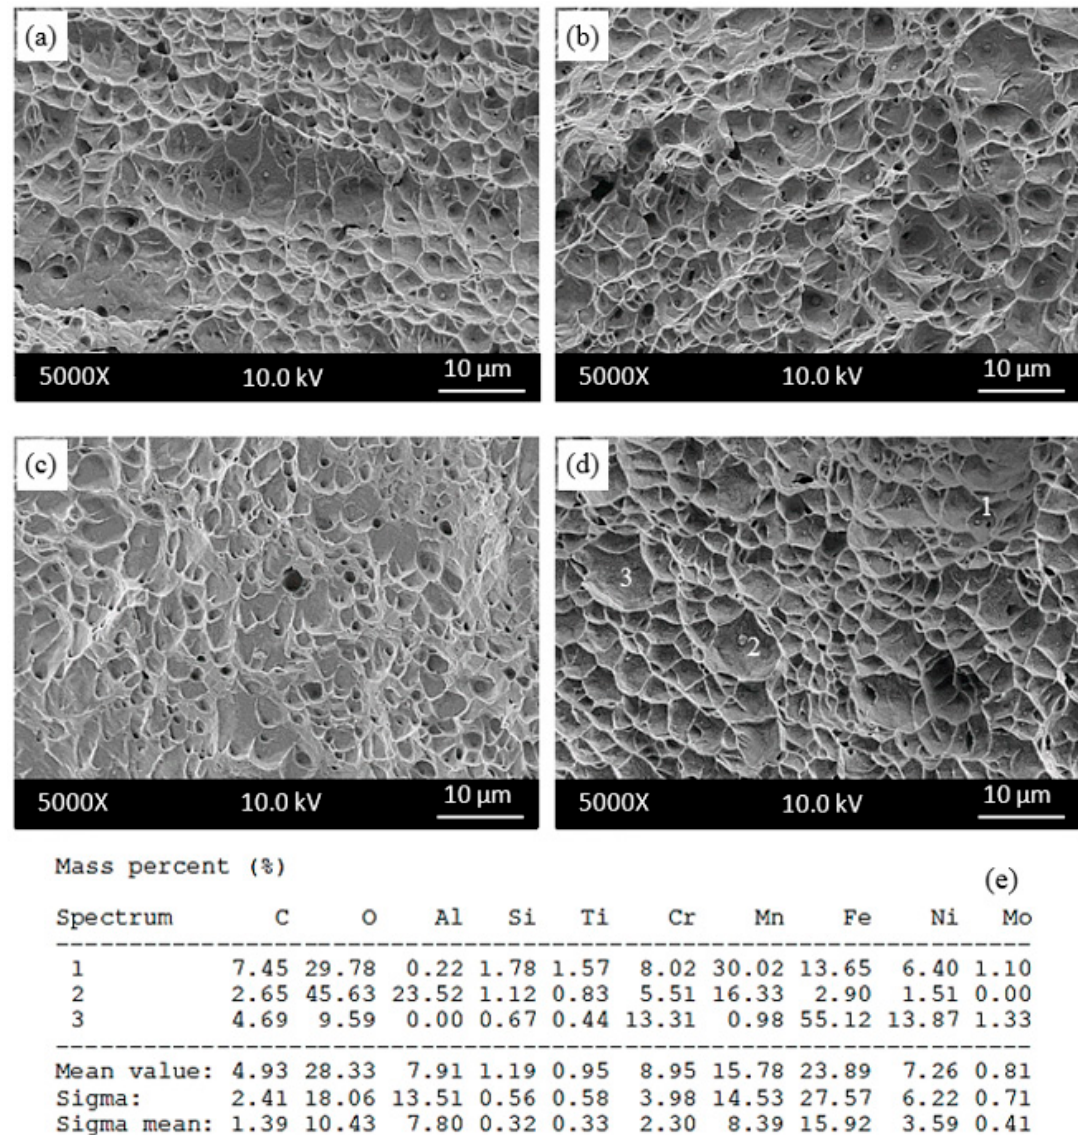
Figure 11. Fractography of as-welded samples tensile tested at ( a ) 25 °C, ( b ) 200 °C, ( c ) 400 °C and ( d ) 600 °C and ( e ) corresponding energy dispersive spectrometry (EDS) of the indicated particles in samples tested at 600 °C.